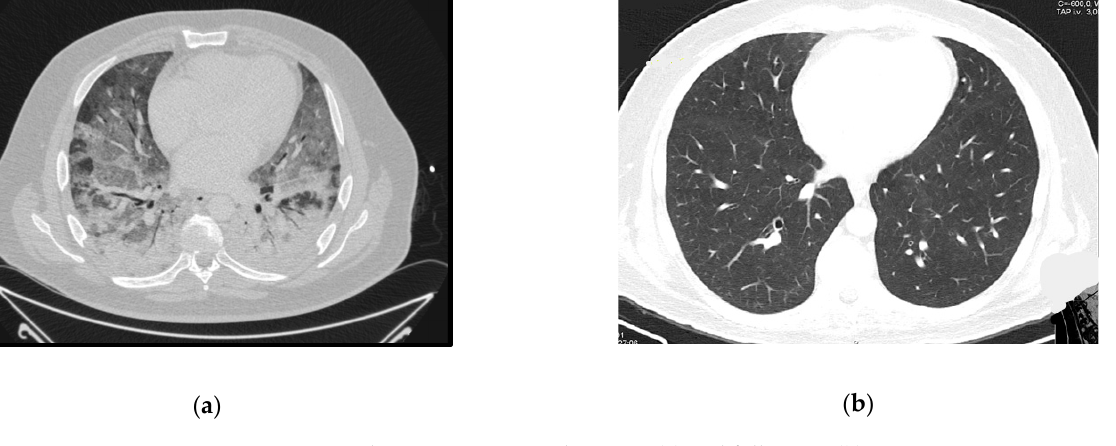
Figure 4. Case 4 thoracic CT-scan at diagnosis ( a ) and follow-up ( b ). After 9 days of ECMO support the patient became delirious and agitated, which caused flow problems in the extracorporeal circuit and eventually led to the need for sedation and subsequent intubation. He completed 21 days of treatment, initially with TMP-SMX, then changed to atovaquone plus primaquine due to hematologic toxicity. ECMO support was maintained for 26